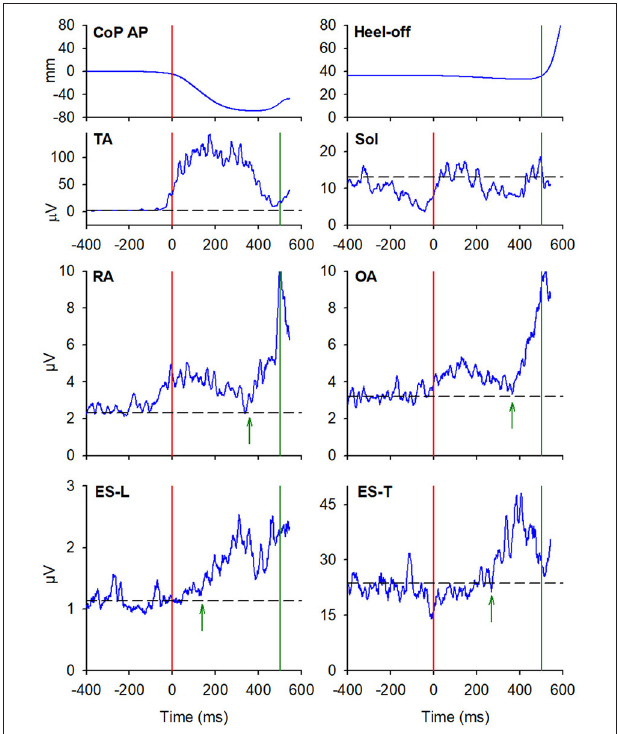
FIGURE 4 | The two uppermost plots display the AP displacements of CoP and the vertical displacement of the leading heel, in the same representative subject of Figures 2 , 3 , when starting gait. Vertical red lines at time 0 mark the onset of the backward CoP shift while vertical green lines mark the heel-off. The remaining plots show the EMG activity recorded in the prime mover (TA, Sol) and trunk postural muscles (RA, OA, ES-L, ES-T) of the right leading side. Green arrows in each plot mark the onset of the changes in EMG activity that follow the CoP onset and precede the heel-off. Black dashed lines represent the average muscle activity in the baseline time window.